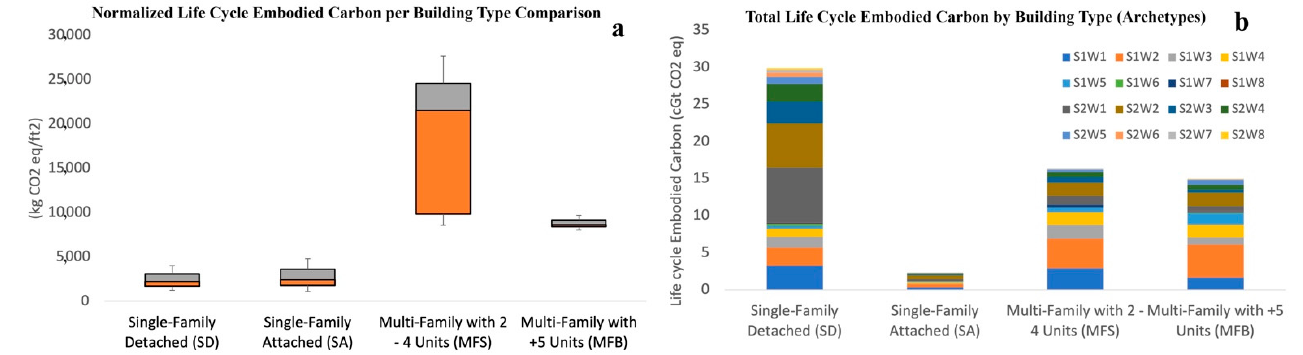
Figure 4. LCEC in the existing US residential building stock: ( a ) normalized emissions per building type, and ( b ) emissions per archetype per housing segment.